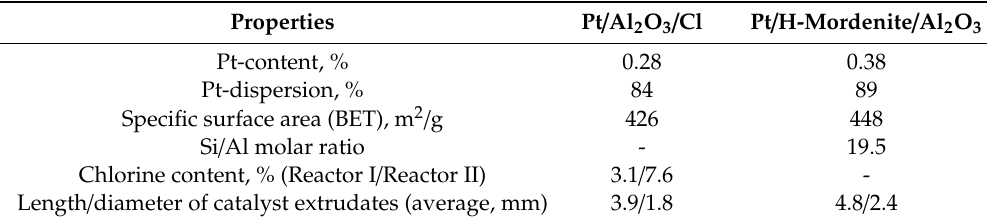
Table 2. The main properties of catalysts used in the experiments.